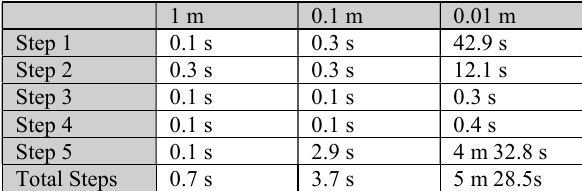
Table 1: Time necessary to process the algorithm for different grid cell sizes for a mesh with 597.197 faces .